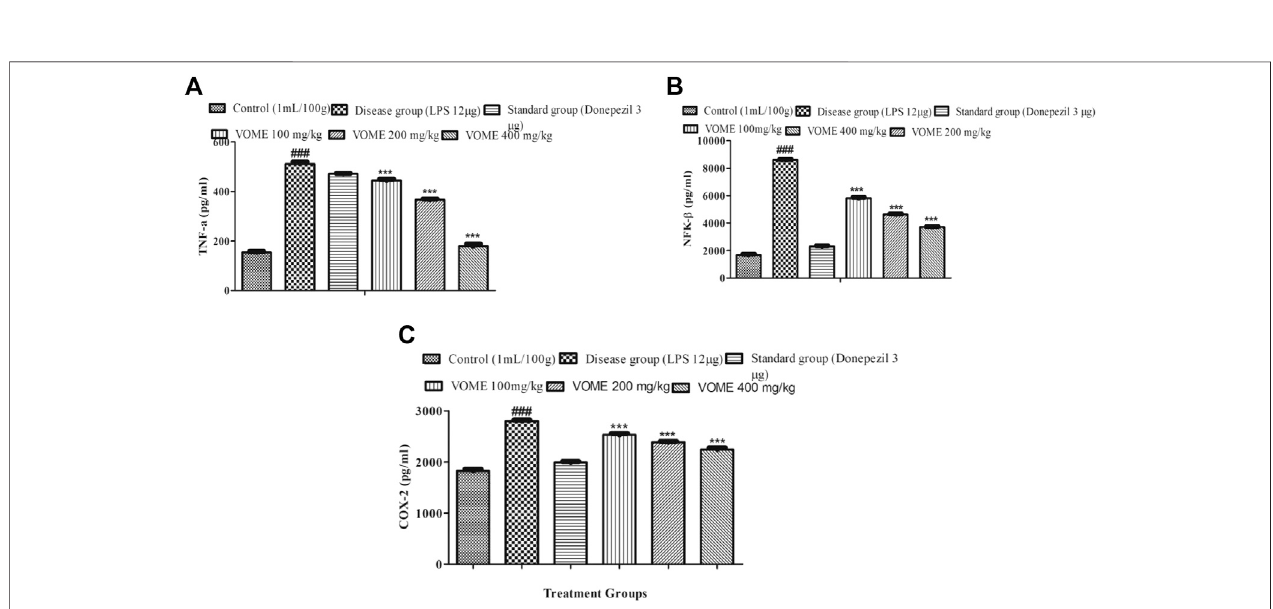
FIGURE 8 | Effect of Viola odorata methanolic extract on in fl ammatory biomarkers. (A) Histogram presenting results of TNF- α in the mice brain. (B) Histogram presenting results of NFK- β in the mice brain. (C) Histogram presenting results of COX-2 in the mice brain. Data are expressed as mean ± SEM, n (cid:1) 10. *** p < 0.001 as compared to the LPS-treated group. ### p < 0.001 as compared to the control group.